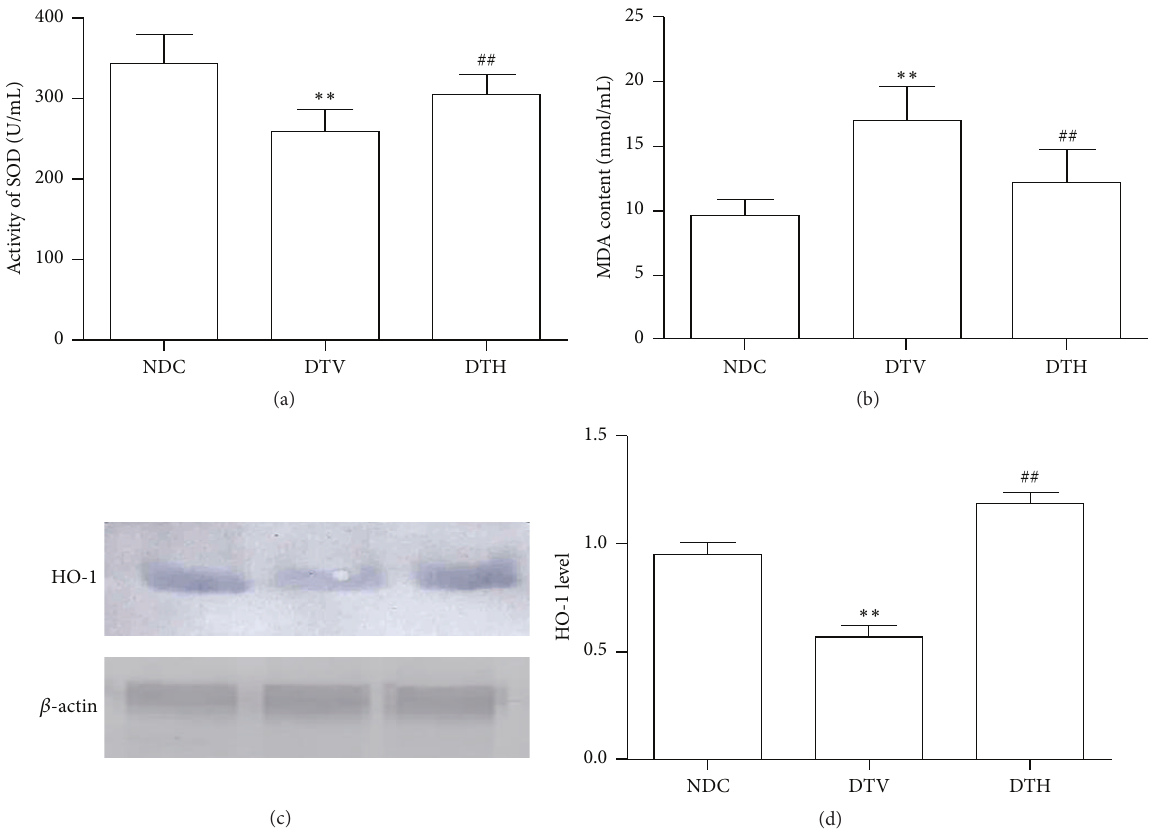
Figure 2: HO-1 enhanced antioxidant effects in diabetic rats. (a) Activity of SOD in serum was significantly corrected by induction of HO-1 in diabetic rats ( ∗∗ 𝑃 < 0.01 versus NDC; ## 𝑃 < 0.01 versus DTV). (b) Induction of HO-1 reduced MDA content in serum from diabetic rats ( ∗∗ 𝑃 < 0.01 versus NDC; ## 𝑃 < 0.01 versus DTV). (c) Expressions of HO-1 were determined. (d) Relative level of HO-1 was increased in diabetic rats treated with hemin ( ∗∗ 𝑃 < 0.01 versus NDC; ## 𝑃 < 0.01 versus DTV).